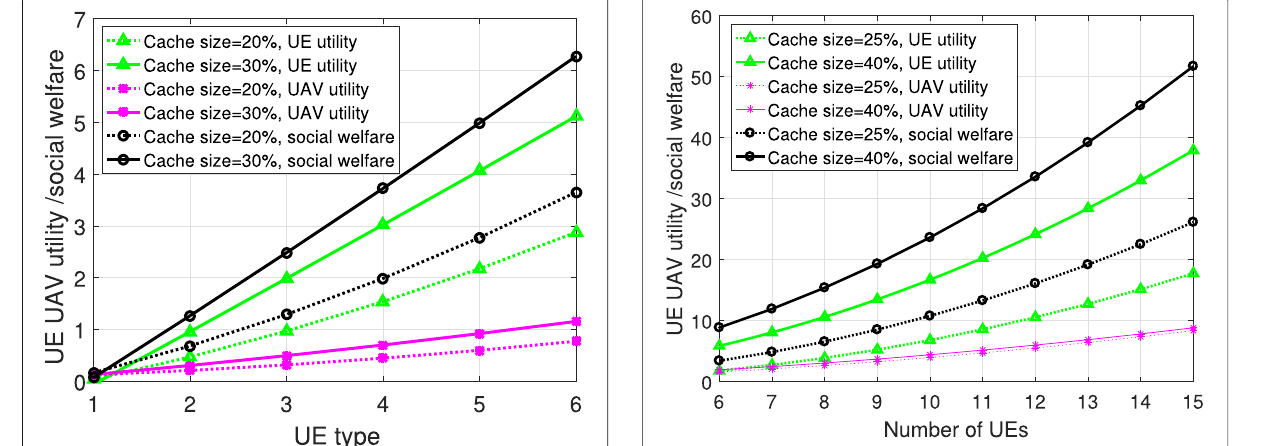
which is due to the limited contents shared by the UEs and their utility functions. Then, we compare the impact of different cache sizes on system performance. We can